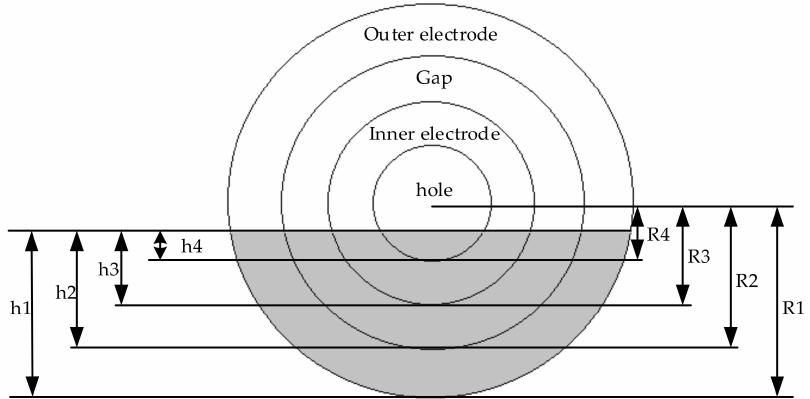
Figure 3. The partial contact area of the circle electrode sensor.